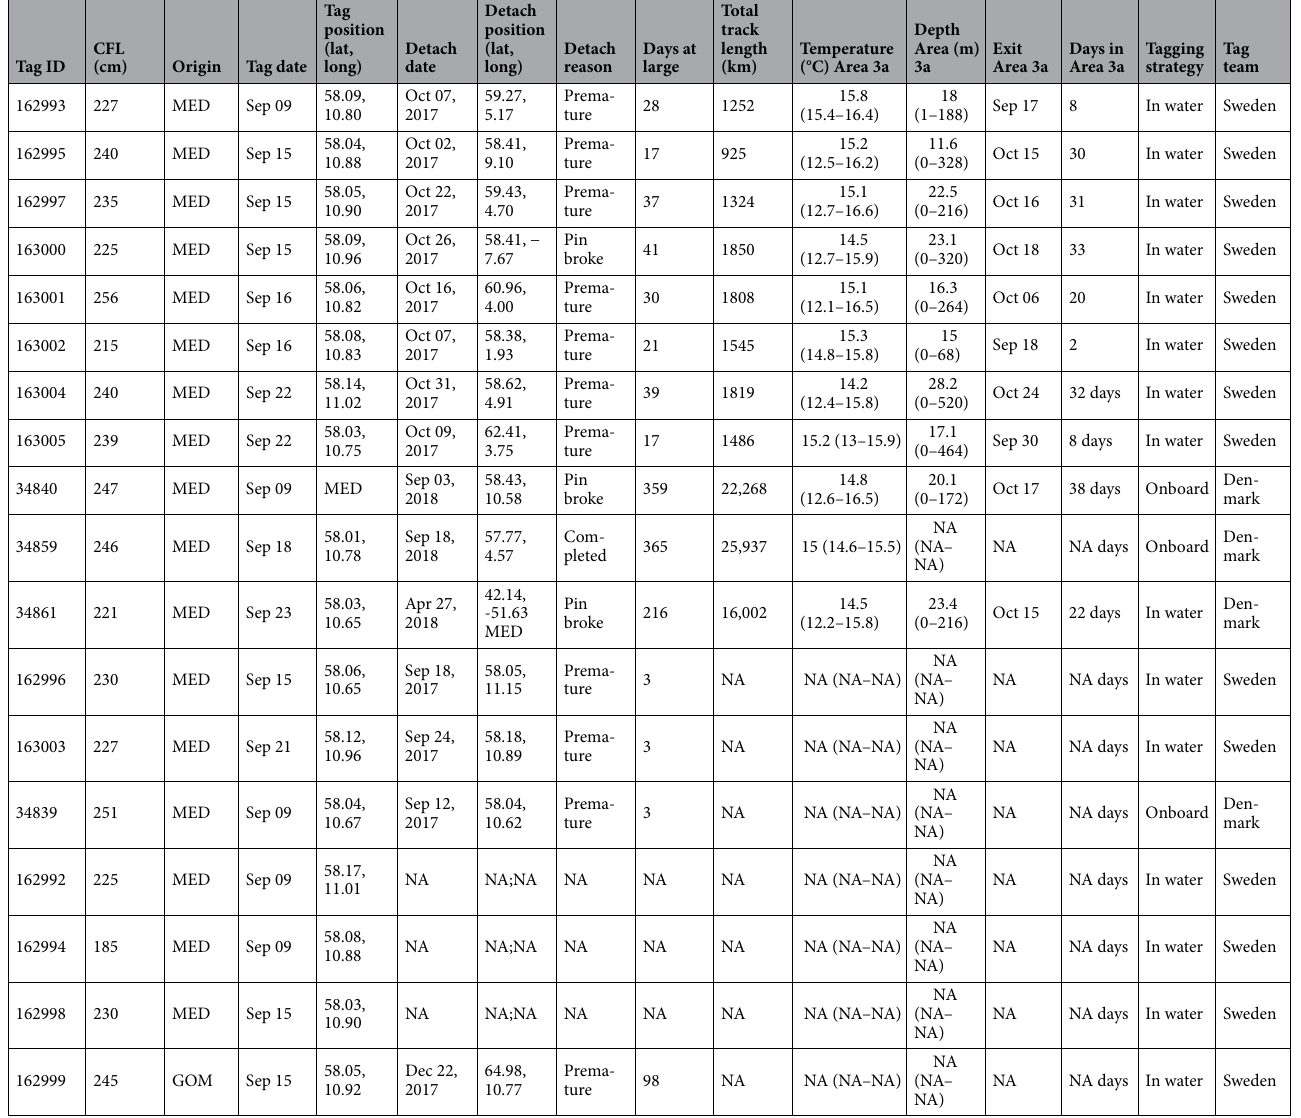
Table 1. Data and summary statistics on tagged Atlantic bluefin tuna tagged in Skagerrak in 2017. Origin refer to the genetic assignment to either the Mediterranean (MED) or Gulf of Mexico (GOM) populations. Premature detachment refers to tags surfacing and initiating transmission before the programmed date for unknown reasons. Pin broke refers to the release pin breaking without the release mechanism initiated (e.g. due to large stress on the pin). Completed means tag initiated release on programmed time. NA indicates data that is not available due to poor data transmission, or tags that never transmitted. Range is provided in